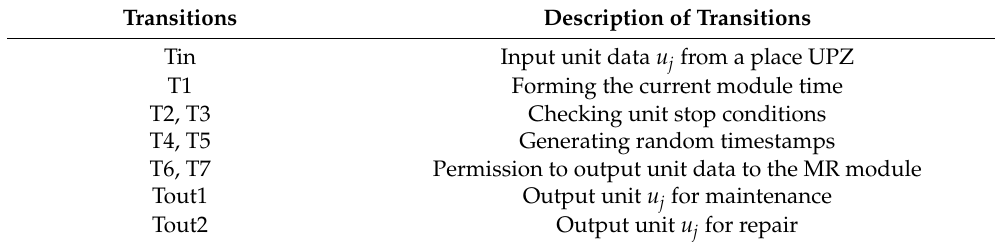
Table A3. Transitions in the RTA